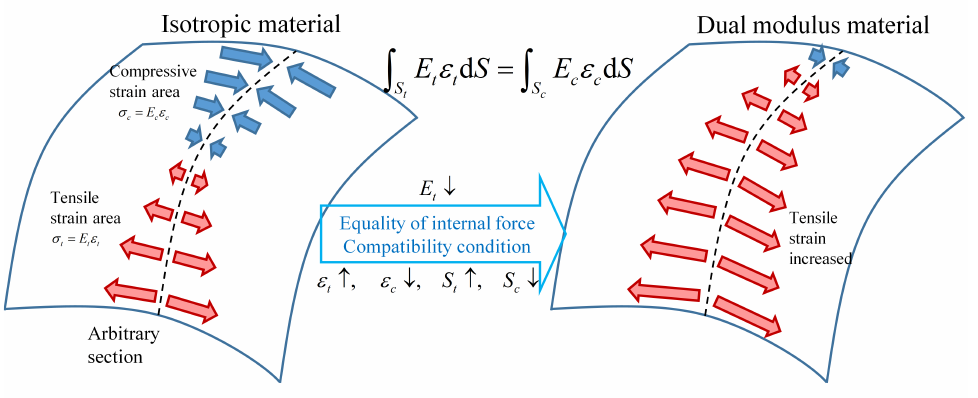
Figure 4. Constrain the magnitude of membrane